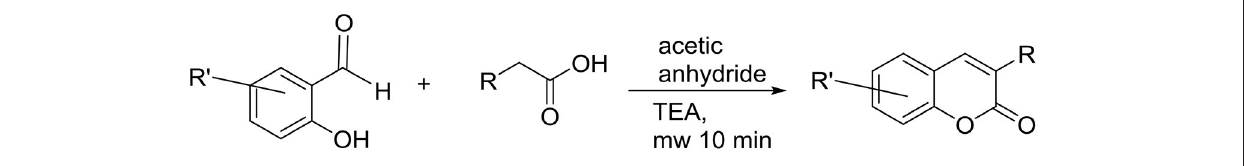
SCHEME 1 | The synthesis of 3-phenylcoumarin